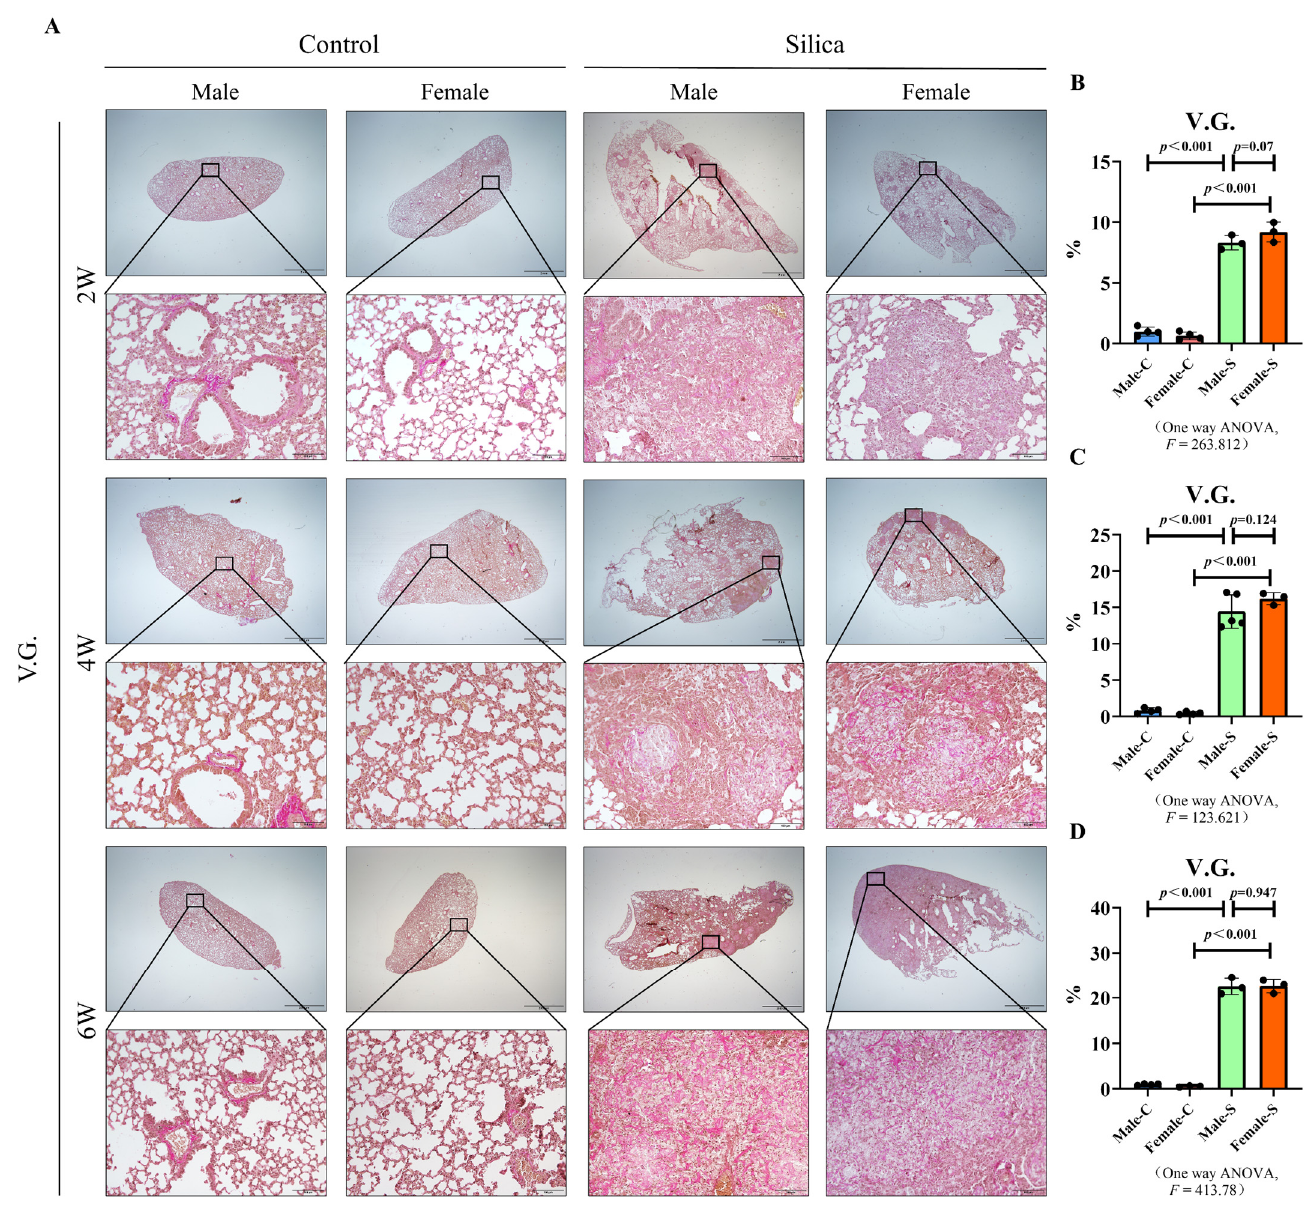
Figure 3. V.G. staining of the male and female mice exposed to silica in two, four, and six weeks, and the control groups. ( A ) V.G. staining of the lung tissues in mice exposed to silica (scale bar = 2000 and 100 µm). ( B – D ) Statistical analysis of the V.G. staining, n = 5 per group (( B )—2W, ( C )—4W, ( D )—6W).